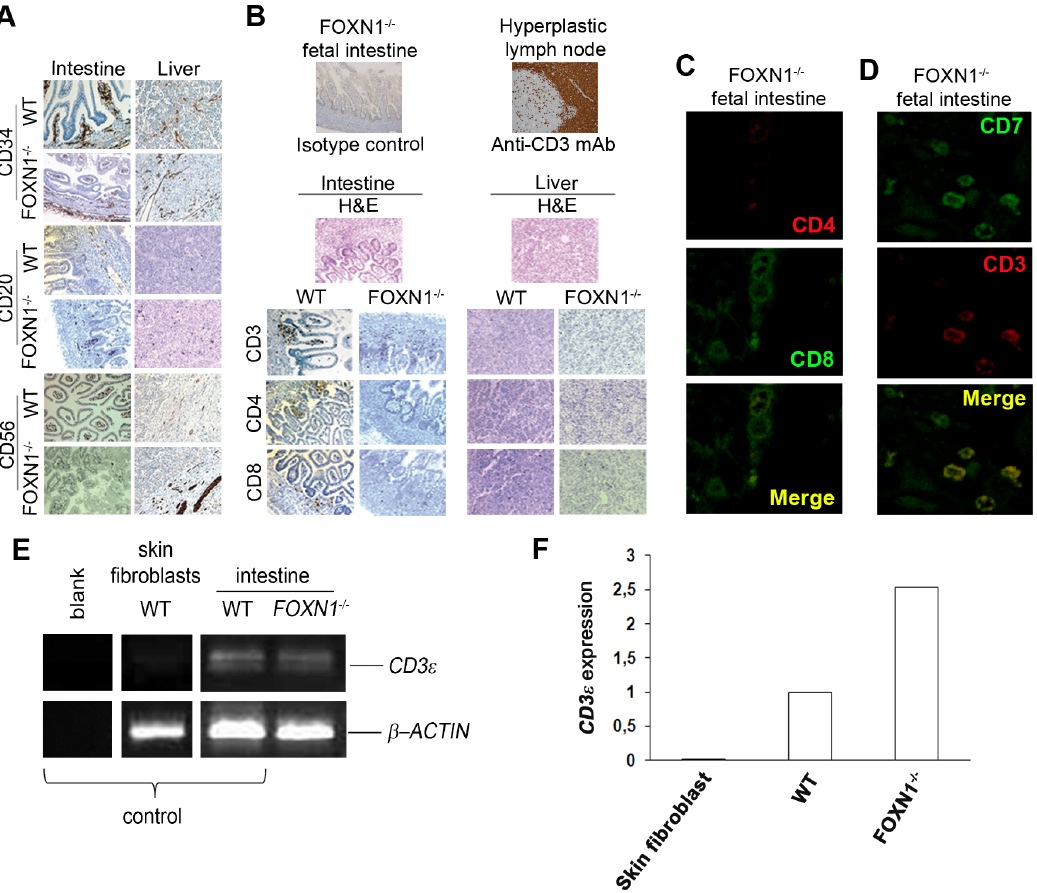
Figure 2. Identification of lymphocytes at extrathymic sites of differentiation in a Nude/SCID human fetus. (A, B) Immunohistochemical detection of lymphocytes at extrathymic sites of differentiation in FOXN1 2 / 2 human fetus (16 weeks of gestation). (A) Stem cells, B cells and NK cells were detected by immunohistochemical stain for CD34 (brown), CD20 (brown) and CD56 (brown) in intestinal and liver sections obtained from a FOXN1 2 / 2 human fetus (16 weeks of gestation) or an aged-matched control fetus. In CD34 and CD20 stained intestine sections from WT and FOXN1 2 / 2 fetuses original magnification was 100x. (B) As negative control, intestinal sections from FOXN1 2 / 2 fetus were counterstained with hematoxylin and with the isotype control (primary antibody omitted) by DAB. As positive control, hyperplastic lymph node sections were stained for CD3 (brown) by DAB. Intestinal or liver sections of FOXN1 2 / 2 human fetus were counterstained with hematoxylin and eosin (H&E). Immunohistochemical analysis of intestinal or liver sections of a FOXN1 2 / 2 human fetus and an aged-matched control fetus using anti-CD3 staining to mark T cells, anti-CD4 staining to mark T helper cells and anti-CD8 staining to mark cytotoxic T cells. DAB, 200x. Representative results from two independent experiments with two distinct samples are shown. (C, D) Confocal microscopy of FOXN1 2 / 2 intestinal sections. (C) Labeling with anti-human CD4 (red) and anti-human CD8 (green). (D) Labeling with anti-human CD7 (green) and anti-human CD3 (red). Representative results from three independent experiments are shown. (E) RT-PCR analysis of CD3 e intestinal expression. CD3 e transcript expression in human skin fibroblasts (negative control), intestinal lymphocytes from WT or FOXN1 2 / 2 fetuses is shown. Blanck, no cDNA. b -actin was used as loading control. Representative results from three independent experiments are shown. (F) Quantitative real-time PCR showing the expression of mRNAs encoding CD3 e (relative to b -actin) in skin fibroblasts (negative control), thymus (positive control) and intestinal tissue of control and FOXN1 2 / 2 fetuses (16 weeks of gestation). Representative results from two independent experiments are